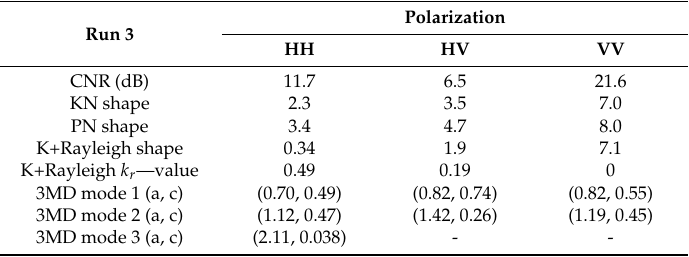
Table 8. Goodness of fit metrics for the model fits in Figure 12. Threshold error is measured at a CCDF of 10 − 4 .